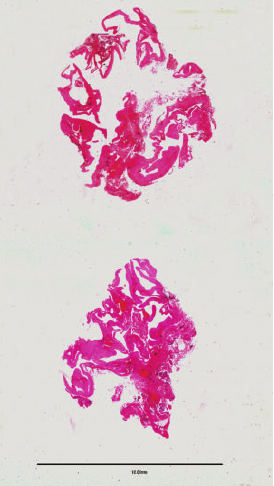
Figure 2: Panoramic view of the lesion in two serial histological sections showing a multilocular cyst (bar: 10mm) (hematoxylin and eosin: